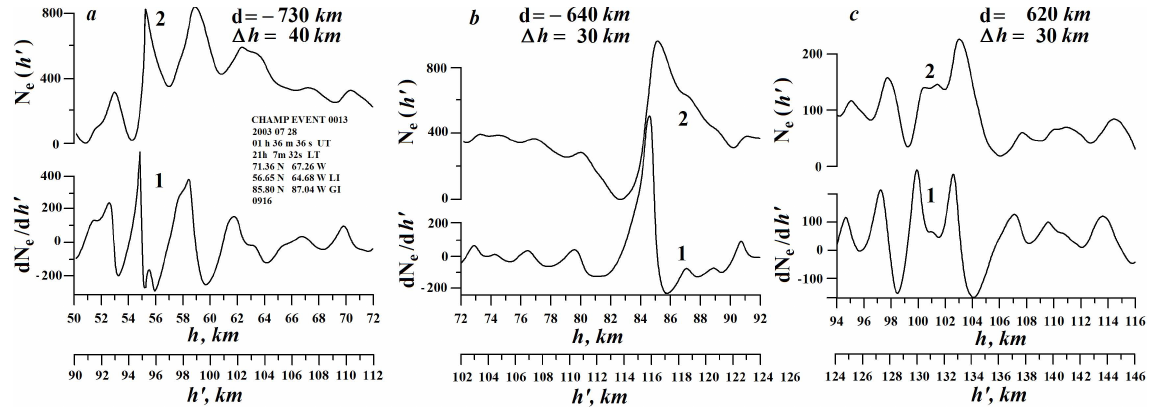
Fig. 11. Restoration of electron density and its vertical